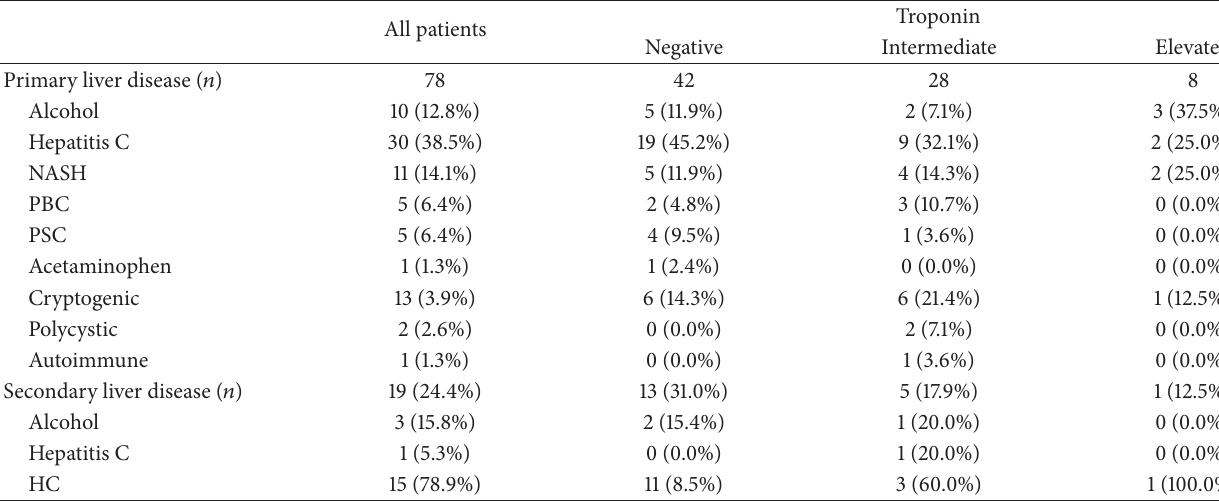
Table 2: Comparisons of types of liver disease.